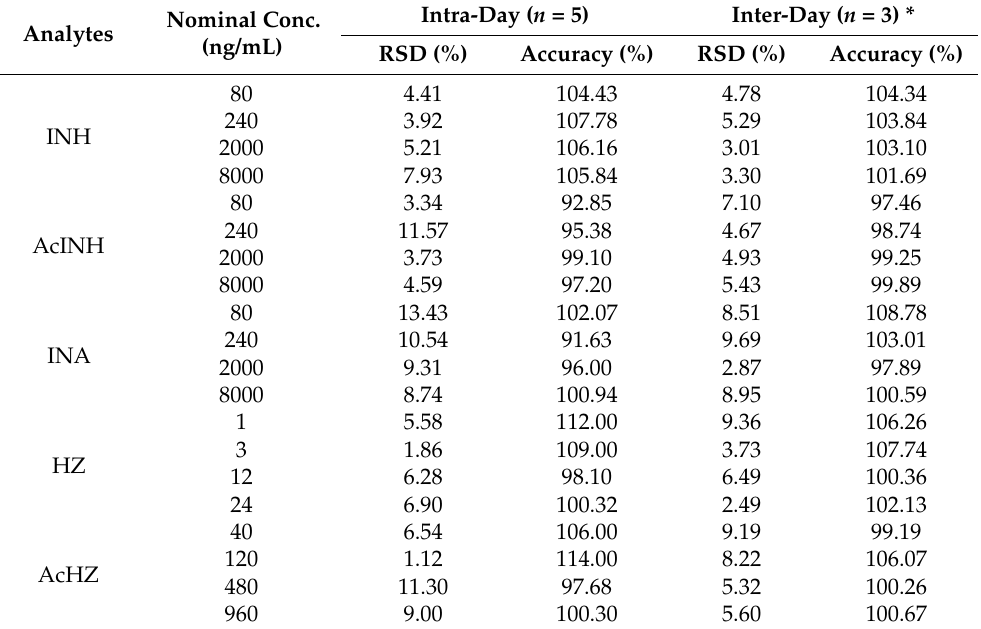
Table 2. Intra- and inter-day accuracy and precision of all analytes.